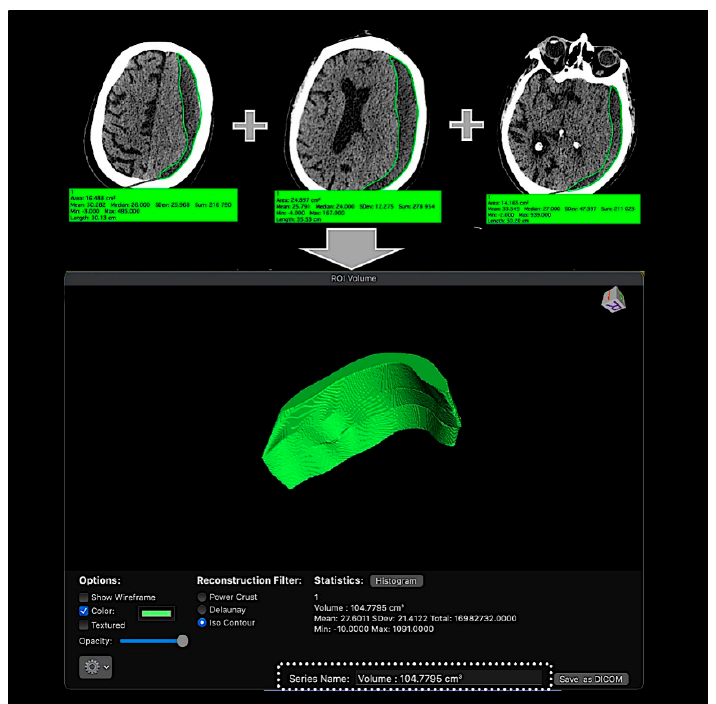
Figure 1. Volumetric analysis of a CSDH for a volume measurement using the OsiriX software. ROI segmentation was performed on each slice of an NCCT, and a volume-rendered model was produced for each scan, with an automated calculation of the entire volume.